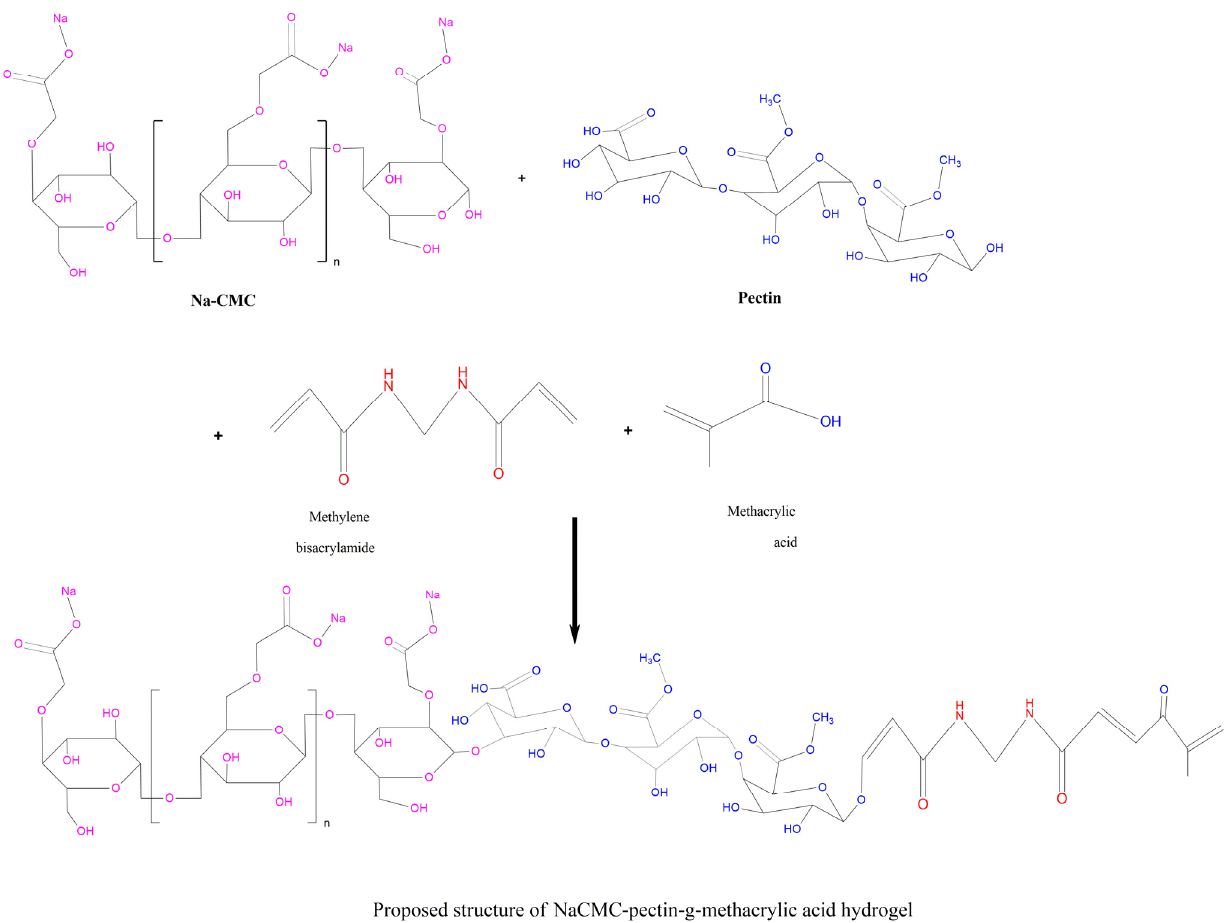
Figure 15. The proposed scheme for possible polymerization among